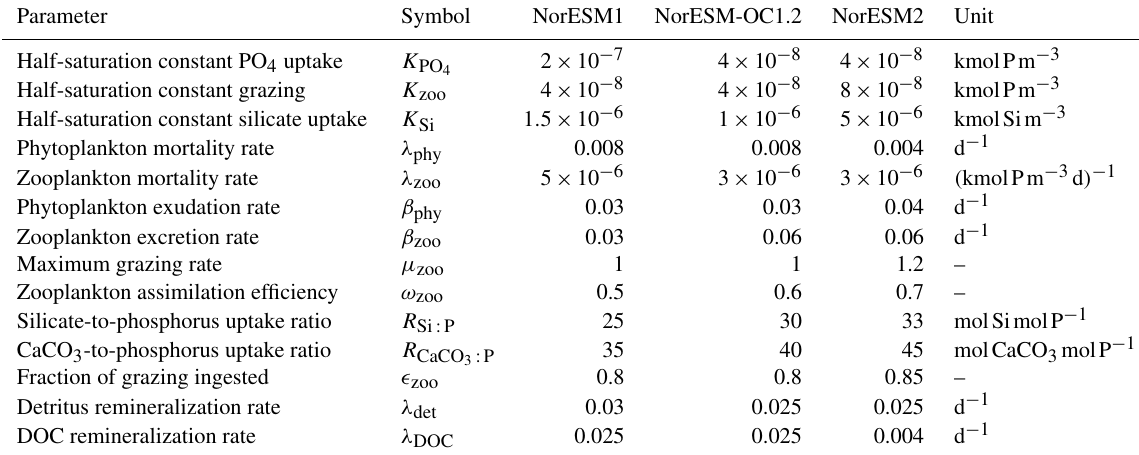
Table 1. Parameter values of the ecosystem parameterizations that have been changed between NorESM1, NorESM-OC1.2, and NorESM2. NorESM-OC1.2 was an intermediate model version (Schwinger et al., 2016) and is included here for completeness and traceability. The naming of parameters follows Ilyina et al.